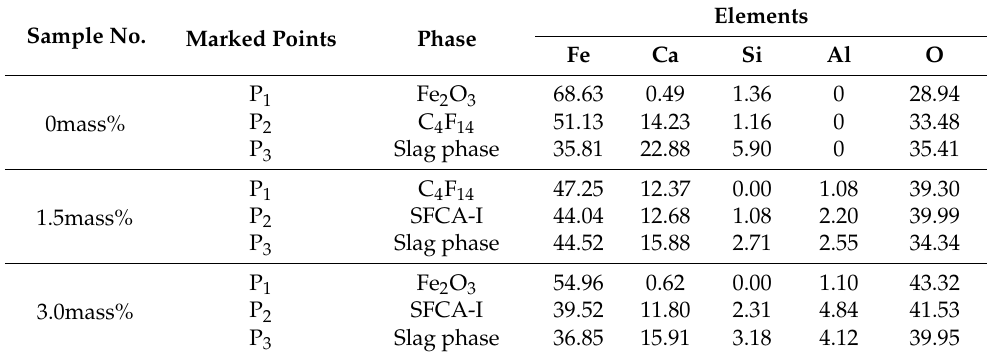
Figure 6. Optical micrographs of cross-sections of water-cooled samples with Al 2 O 3 addition at different temperatures. CF: CaFe 2 O 4 ; C 4 F 14 (Ca 4 Fe 14 O 25 ); SFC: Ca 2.73 Fe 2 + Ca 3.18 Fe 15.48 Al 1.34 O 36 ; SFCA: Ca 5 Si 2 (Fe Al) 18 O 36 ; H: Fe 2 O 3 ; γ -C 2 S: γ -Ca 2 SiO 4 . Figure 7 and Table 3 show the SEM photos and EDS results of the samples, confirming the XRD results. With the increase of the mass percentage of Al 2 O 3 in the melt, the crystalline phase would change, and Al 2 O 3 promoted the transition from SFCA-I to SFCA while inhibiting the formation of C 4 F 14 . Table 3. EDS results of the crystallized phases in the samples with different mass pct of Al 2 O 3 . Sample No. Marked Points